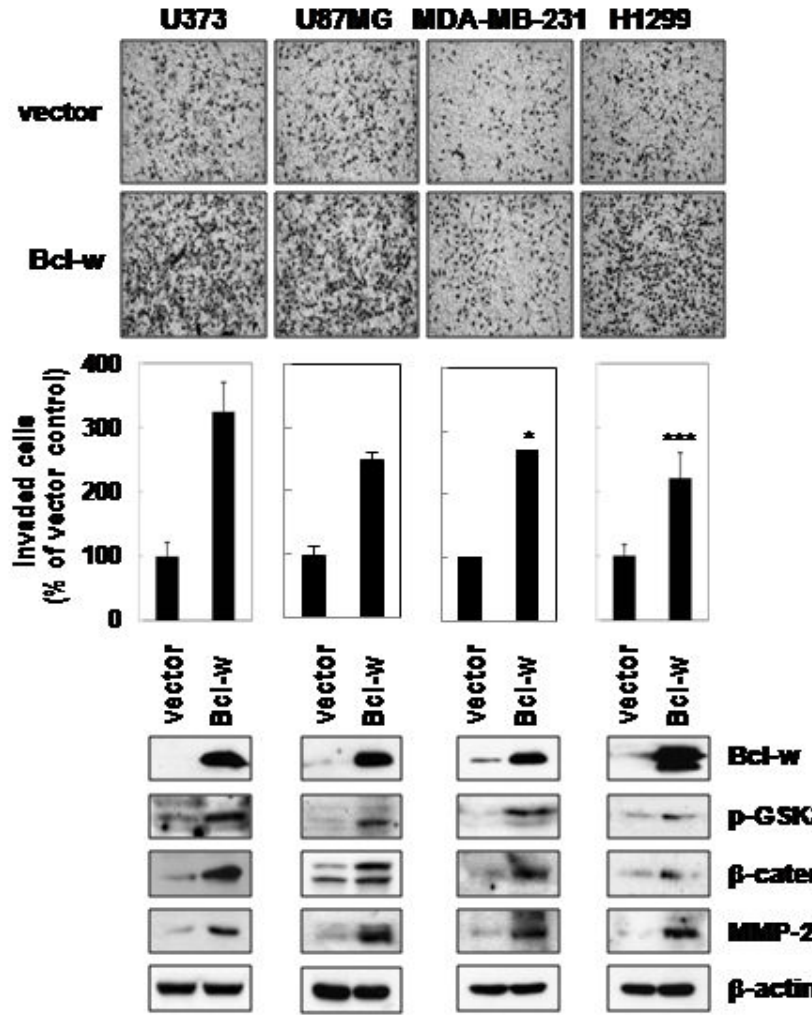
Figure 7. Bcl-w contributes to invasiveness in various cancer cell types including U373, U87MG, MDA-MB-231 and H1299. Cell lysates were prepared using vector- and Bcl-w-transfected cells, and Western blotting performed to compare p-GSK3β, β-catenin and MMP-2 protein levels. Transfectants were additionally subjected to Matrigel invasion assays. *, p < 0.01, ***, p < 0.0005 versus vector control, n =